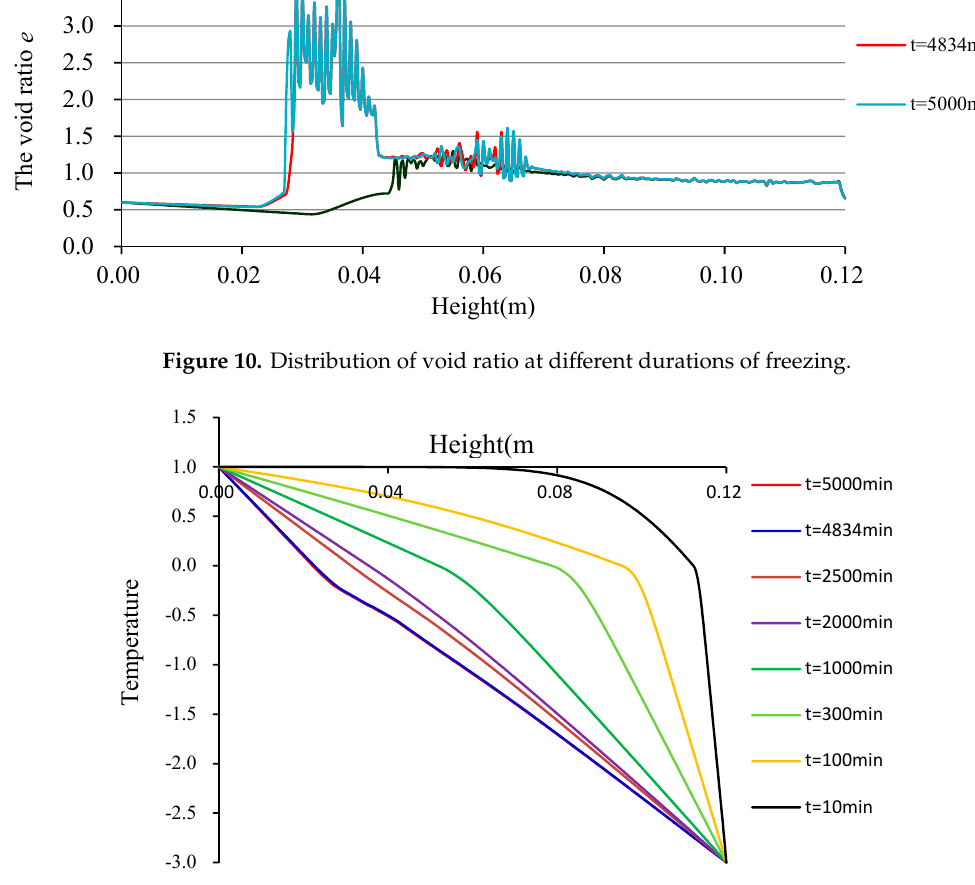
Figure 11. Distribution of temperature at different times.